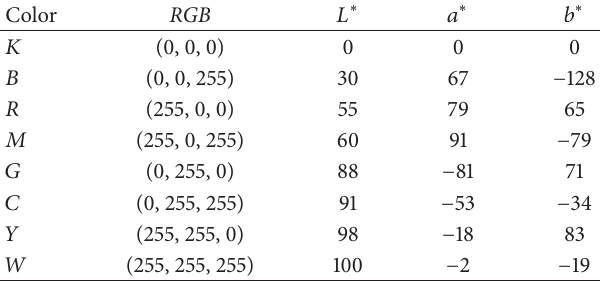
Table 1: RGB and CIELAB values of the vertices for